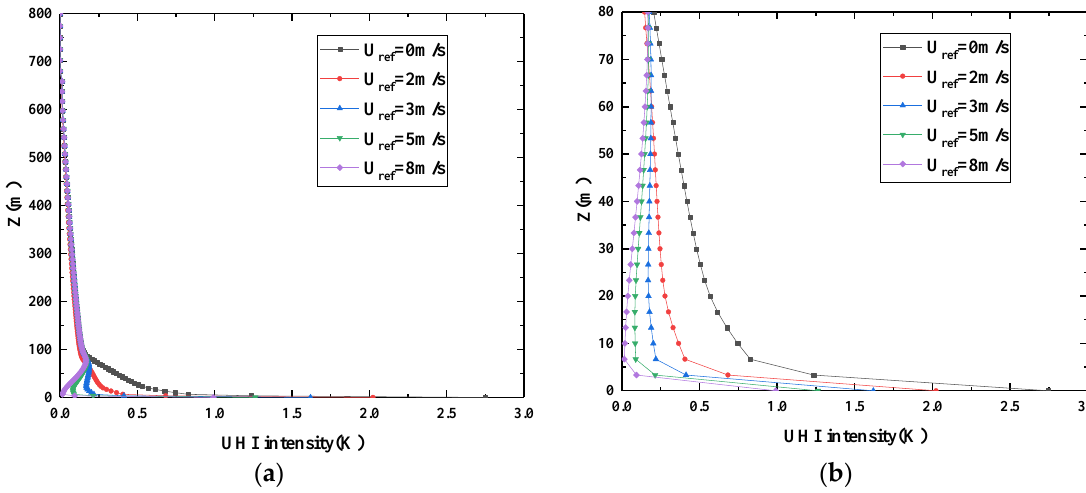
Figure 11. The vertical profiles of the UHI intensities at different ambient crosswinds in the plane x = −2000 m: ( a ) within the computational height and ( b ) at the urban canopy’s heights.